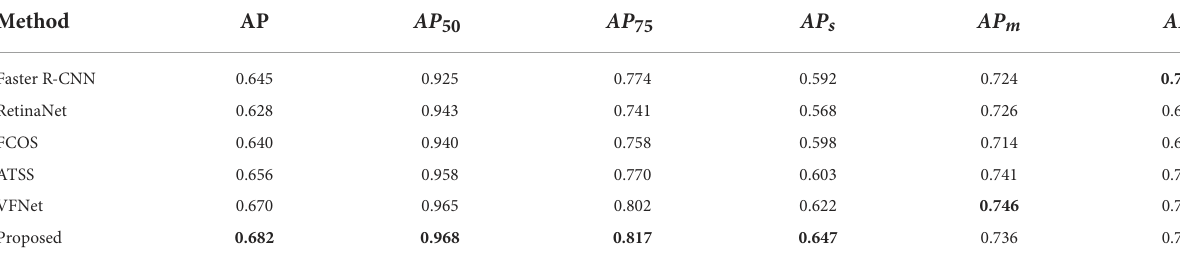
TABLE 2 Performance of other target detection methods and the proposed algorithm on SSDD.